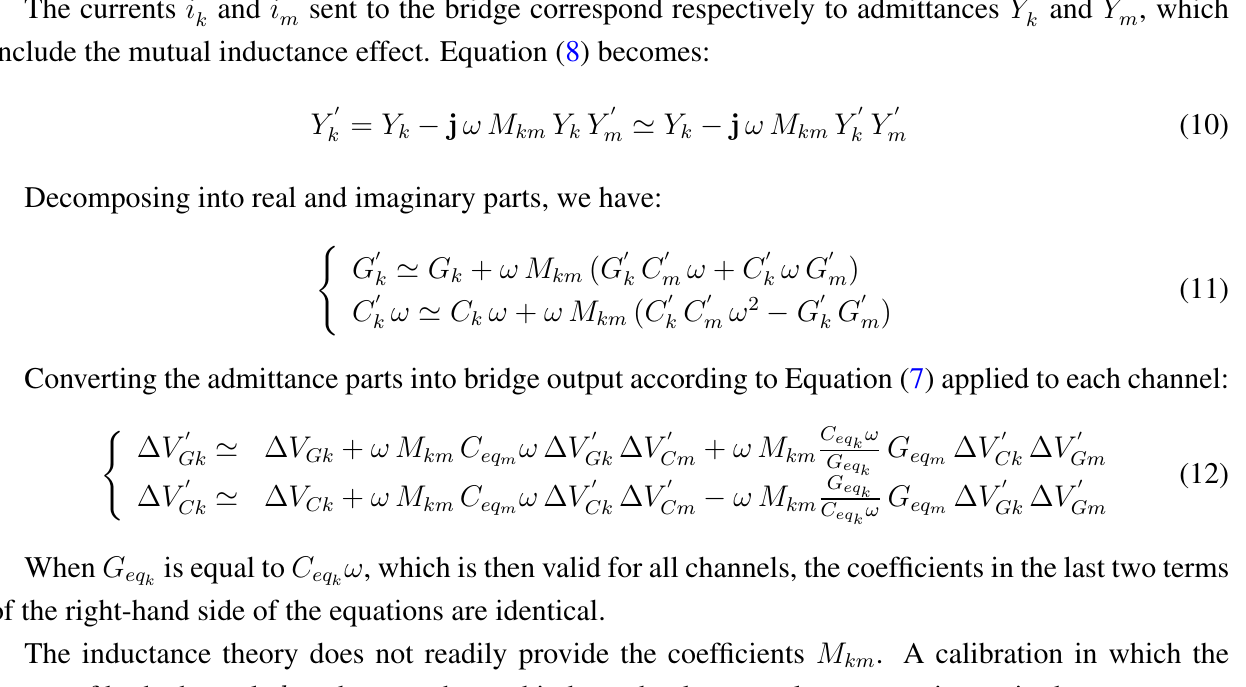
due to the influence of channel m km